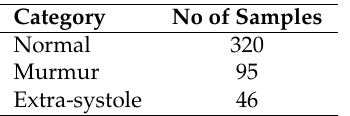
Table 2. Dataset-B